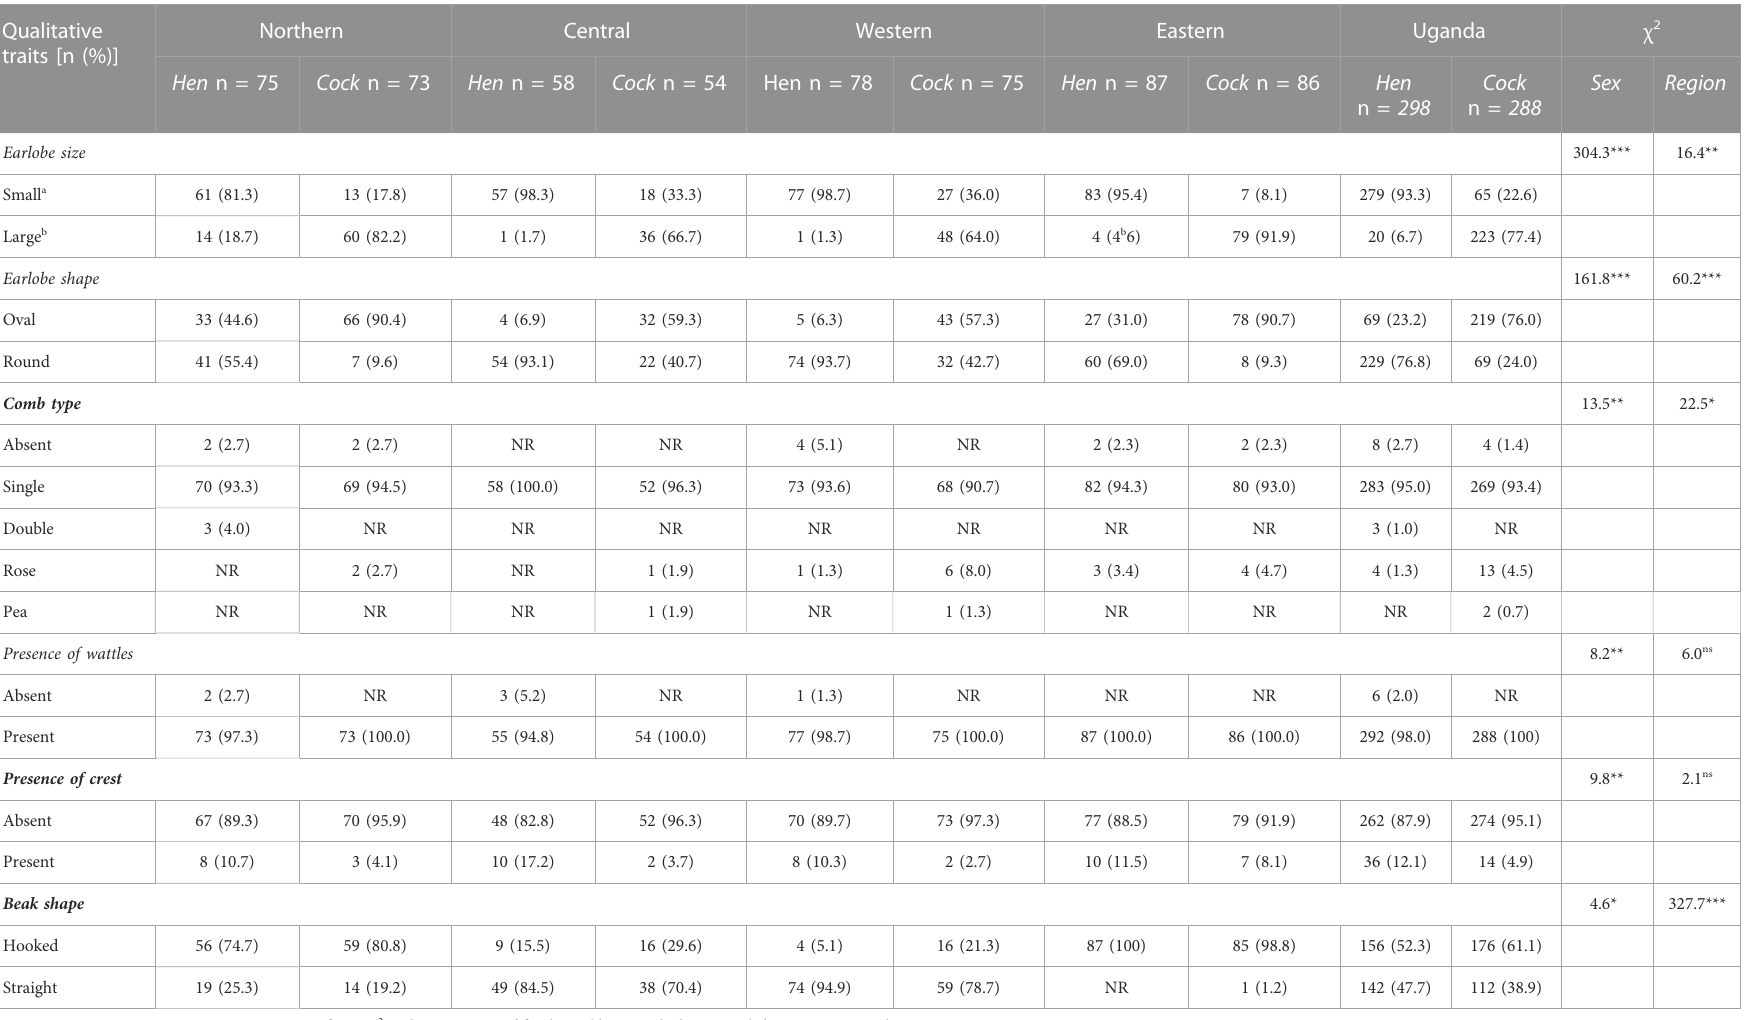
TABLE 6 Variations in the descriptive head features of indigenous chickens in Uganda. Qualitative traits [n